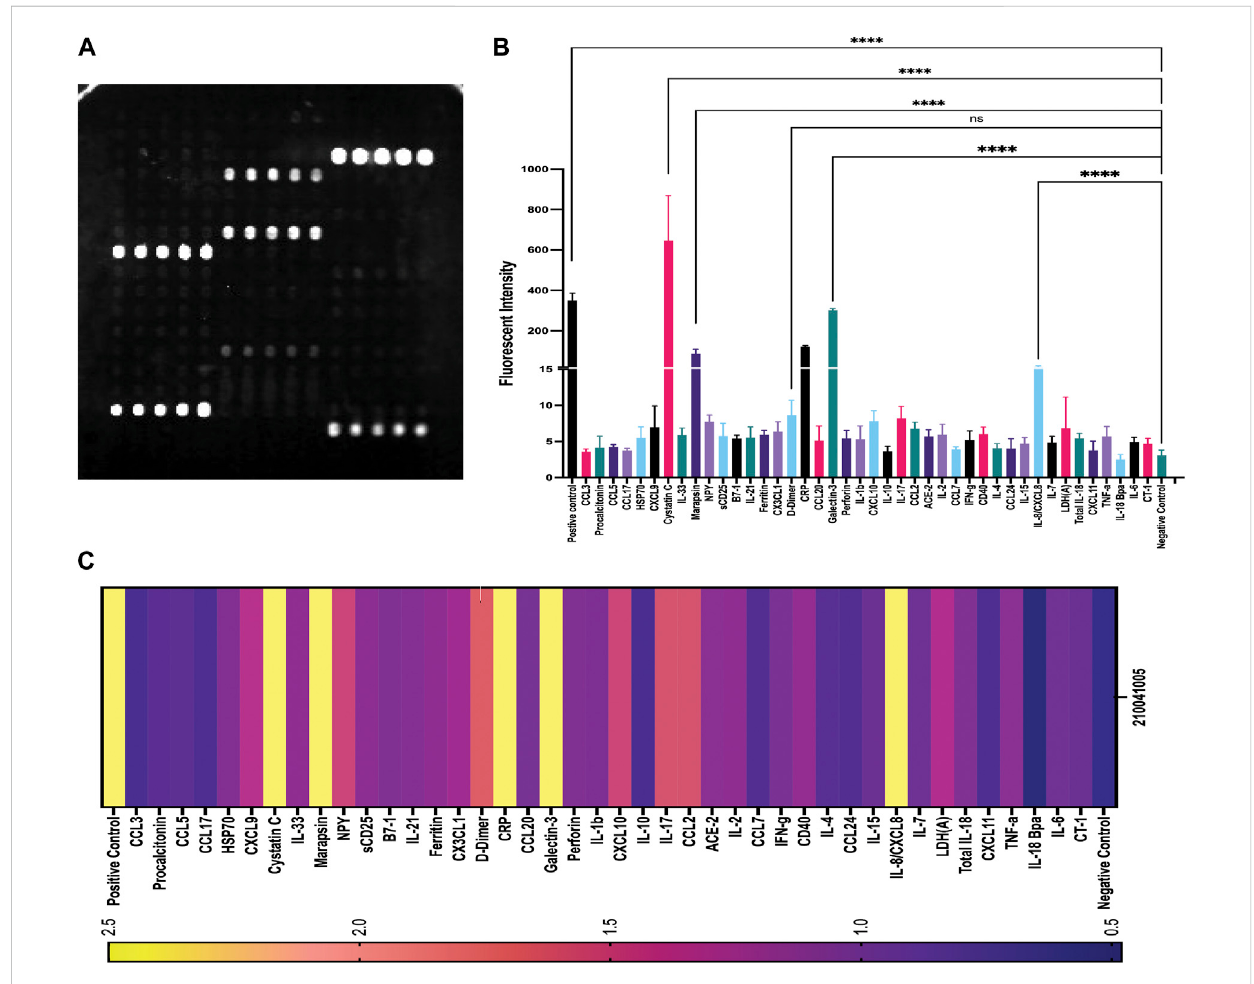
FIGURE 3 Example of patient(210041005) data generated from GCFP assay. (A) Forty-two unique capture antibodies were immobilized on regions of interest insetsof5ROIsonthechipandpatientsamplenumber210041005wasrunoverthechipandanimageoftheGCFPsensorchipoutputwascaptured. (B) Fluorescent intensity within the ROIs were collected as previously described, detecting cystatin C, Marapsin, D-dimer, galaectin-3, and IL-8. (C) A heat mapofthedetection ratiowasgeneratedandshowsdetection ofthesameanalytes asin (B) .One-wayANOVAanalysis wasperformed(*= p < 0.05, ** = p < 0.01, *** = p < 0.001, **** = p < 0.0001. The data are presented as the average of fi ve ROIs for each analyte ( ± standard error of the